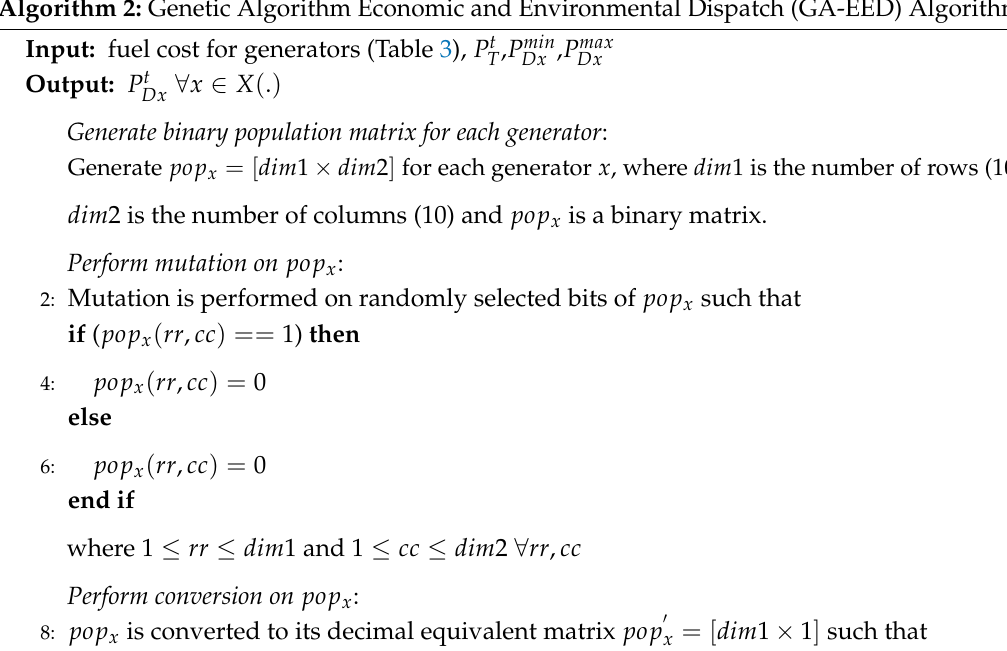
Algorithm 2: Genetic Algorithm Economic and Environmental Dispatch (GA-EED)